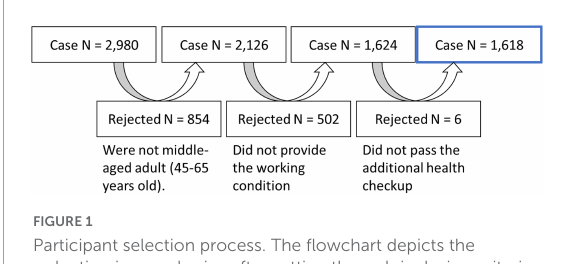
FIGURE1 Participant selection process. The flowchart depicts the reduction in sample size after vetting through inclusion